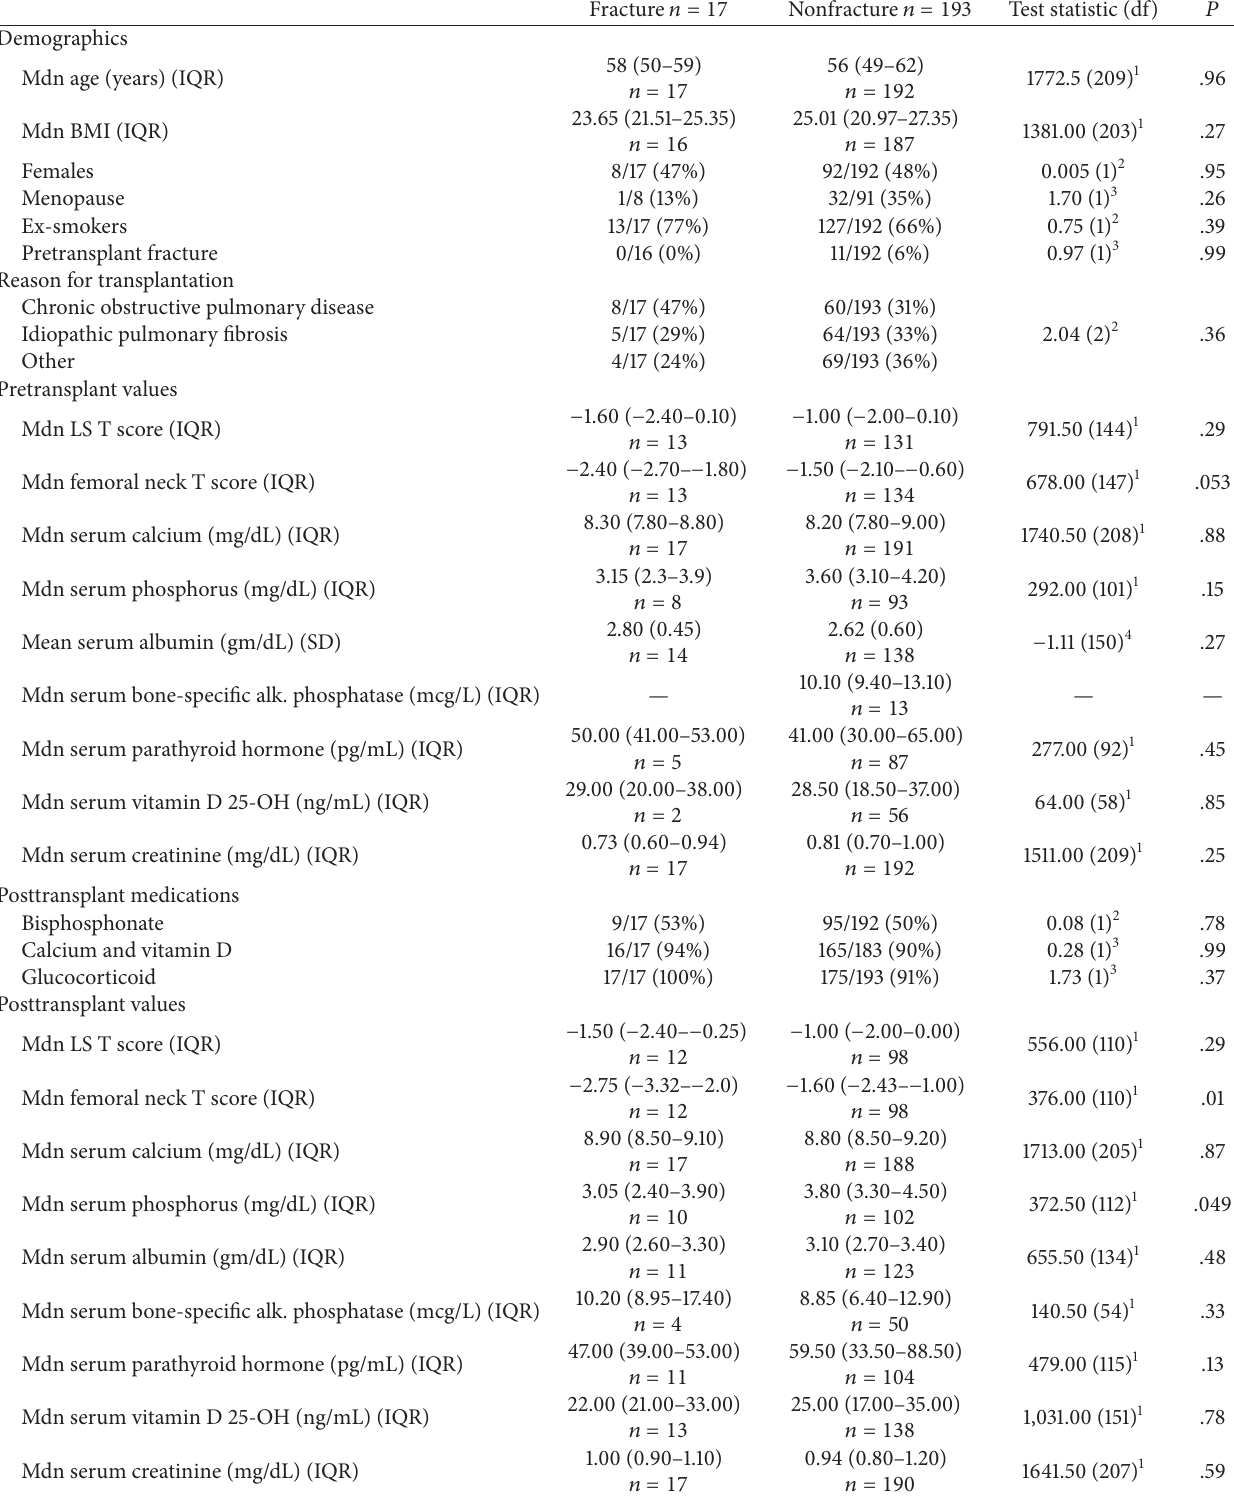
Table 1: Comparison of those with fractures versus no fractures in the lung transplant